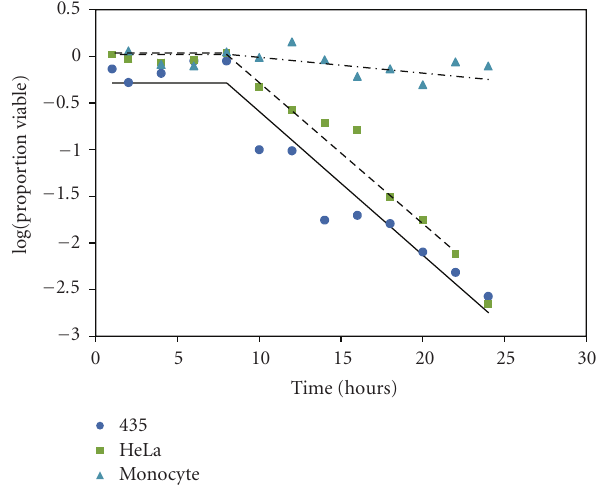
Figure 4: Timed toxicity response of cell lines 435, HeLa, and monocyte control to 2.05 mg/mL of extract from Atriplex confer- tifolia .